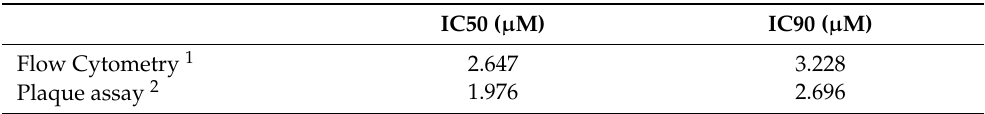
Figure 3. The DV2 peptide inhibits ZIKV infectivity in vitro cultured Vero cells. Vero cell monolayers were infected with ZIKV (MOI = 1.0) in the presence of the DV2 (DV2) or Ph22 (Control) peptides. The impact of the treatment with the DV2 peptide on virus infection was measured at 24 hpi. ( a ) Percentages of infected cells determined by flow cytometry. ( b ) Viable ZIKV titers (PFU/mL) determined by plaque assay using culture supernatants of infected cells. Cells incubated with viruses treated with Ph22, DMSO, or culture medium (NT) were used as negative controls. The data are presented as mean ± SEM (bars) from three independent experiments. Statistically significant differences were determined using two-way ANOVA with Bonferroni correction (*** p < 0.001 and **** p < 0.0001, compared to the DMSO control). Table 1. DV2 peptide concentrations required to inhibit ZIKV infection by 50% (IC 50 ) or 90% (IC 90 ), determined by different methods.